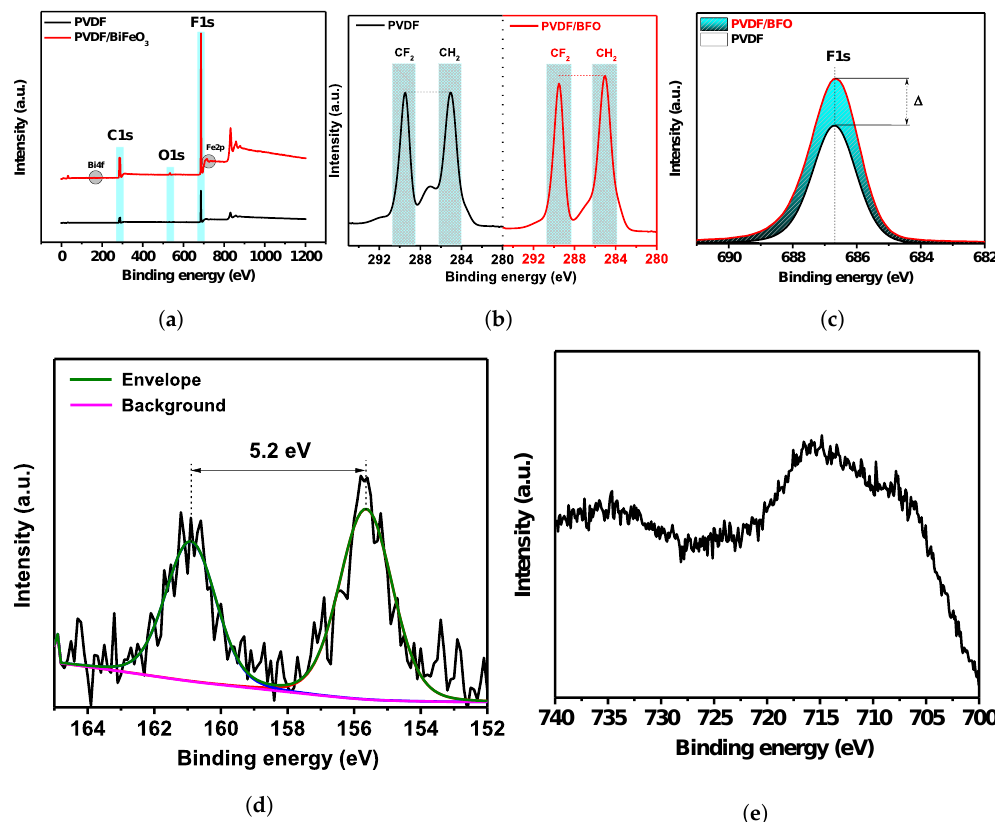
Figure 3. XPS PVDF and PVDF/BFO spectra: ( a ) wide spectrum, ( b ) high-resolution C1s spectra, ( c ) high-resolution F1s spectra, ( d ) high-resolution Bi4f spectra, ( e ) high-resolution Fe2p spectra. The thermal stability of the PVDF/BFO membrane was studied by DSC. Figure 4 shows the heating and cooling thermograms of the samples. The melting endotherm is characterized by a broad peak at 163.7 °C with a shoulder in the low-temperature region. This may indicate the presence of crystals of different sizes, crystal perfection, and the pres- ence of different phases [51]. The crystallization isotherm indicates that the crystallization temperature ( T C ) of the sample is 141.2 °C. Compared to pure PVDF [52] obtained by the same methodology, the crystallization temperature is higher by 10.8 °C. In addition, the TGA measurement was carried out simultaneously with the DSC. The results showed that the change in mass of the sample up to 190 °C is less than 1%. Thus, the results indicate high thermal stability of the obtained materials.